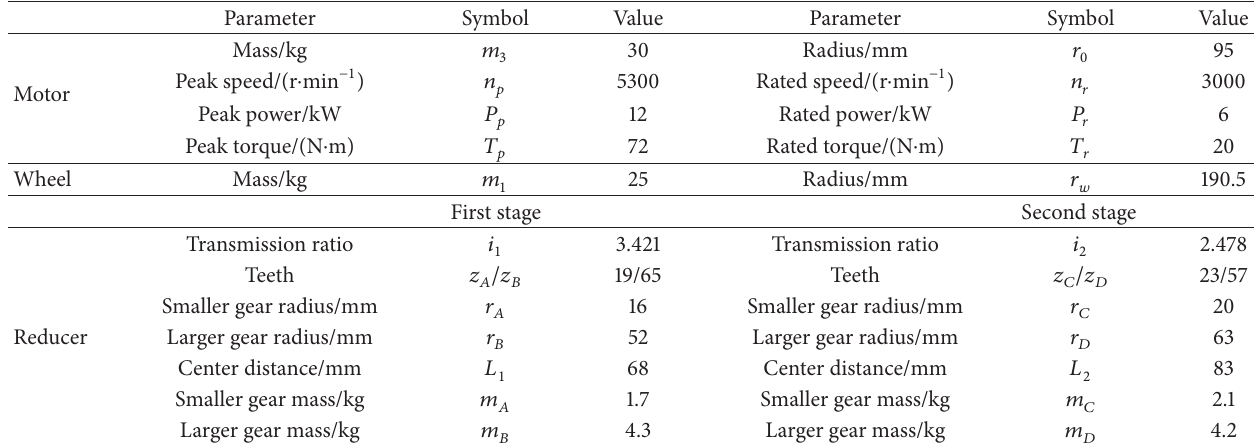
Table 1: Power system